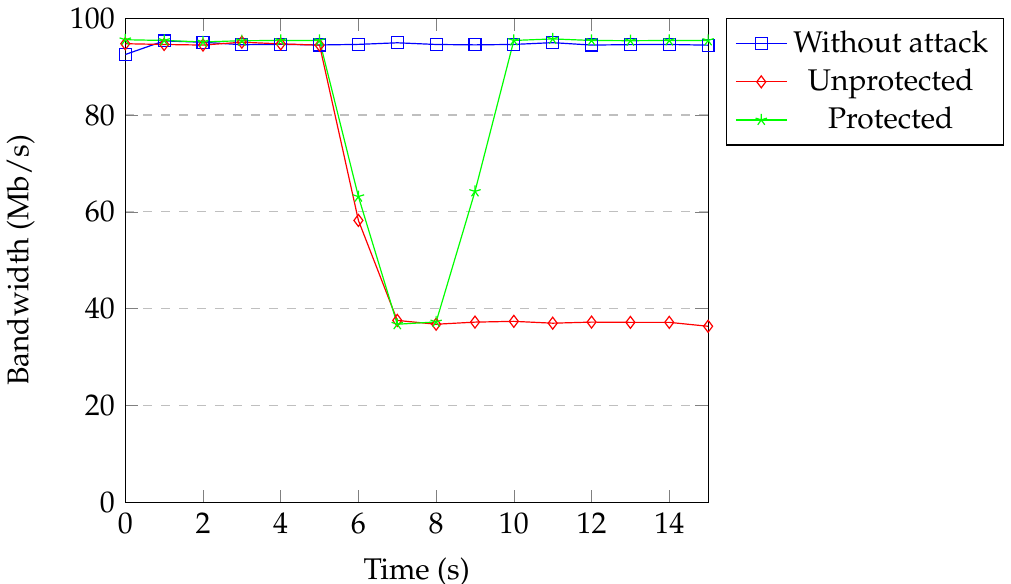
Figure 17. Available bandwidth under SYN flood without spoofing.